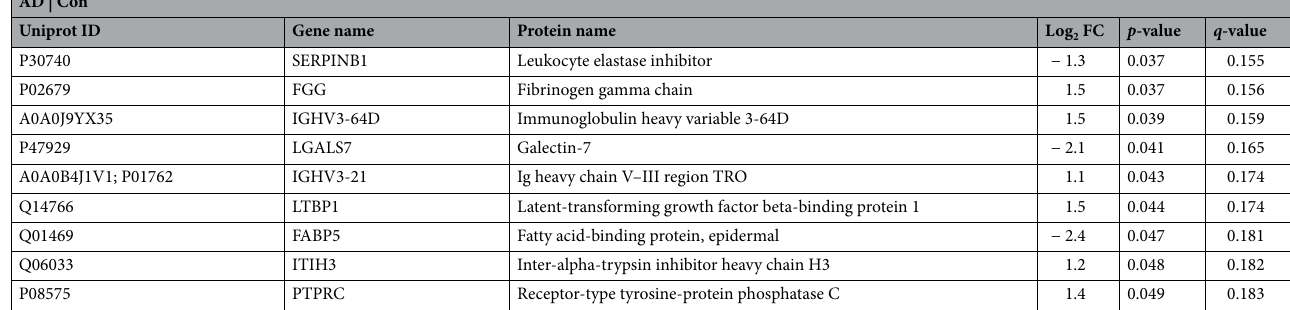
Table 2. Significantly expressed proteins comparing AD patients with healthy controls. *Permutation-based FDR in Perseus indicated a very low q -value approximated to 0. Benjamini–Hochberg indicated a q -value of 0.0006. The reported q -value is estimated to be below